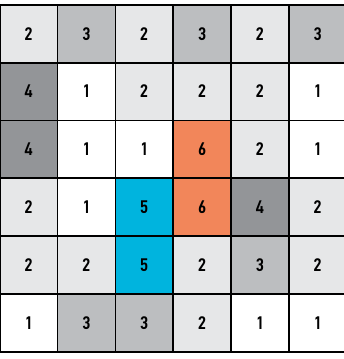
Fig. 8. An example of two-dimensional grid